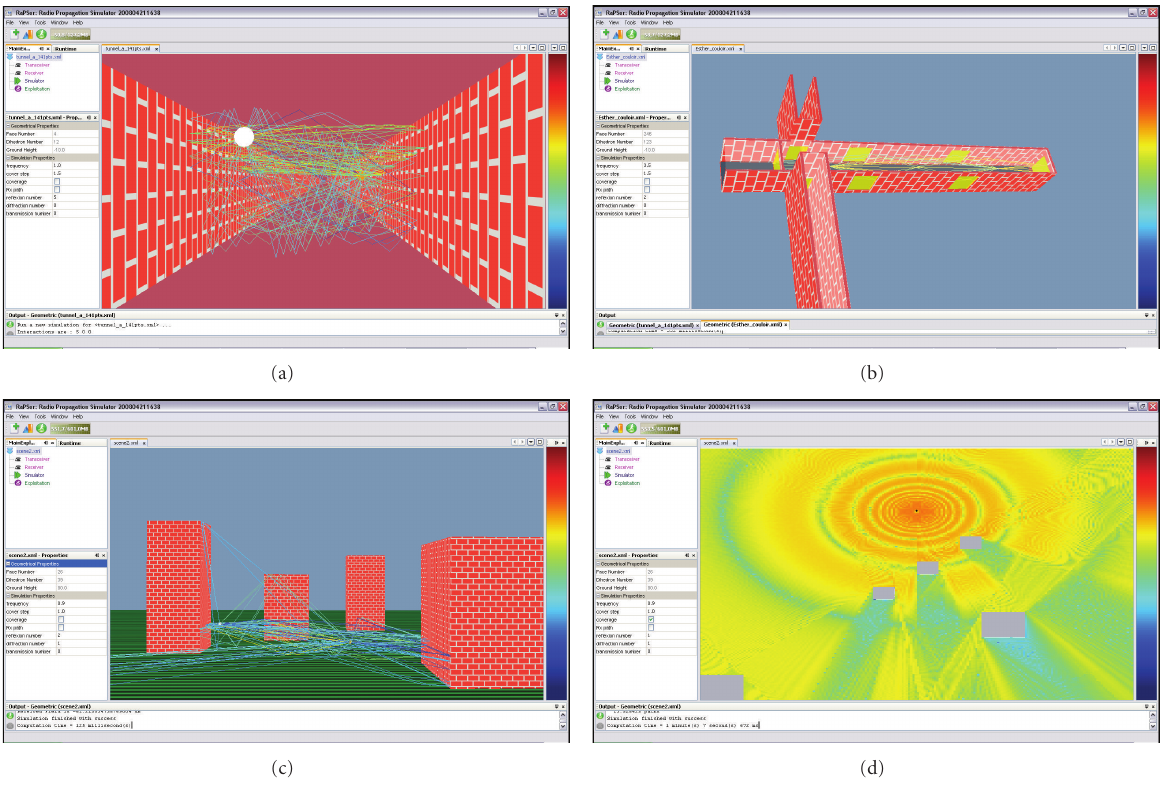
Figure 6: RAPSOR interfaces: 3D paths in (a) tunnel environment, (b) indoor environment, (c) outdoor environment, and (d) is coverage area in outdoor environment.